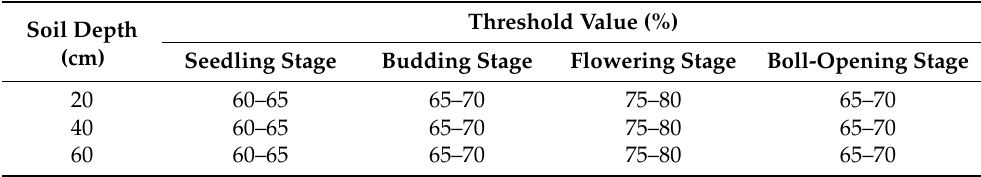
Table 2. Irrigation thresholds of automatic drip irrigation under